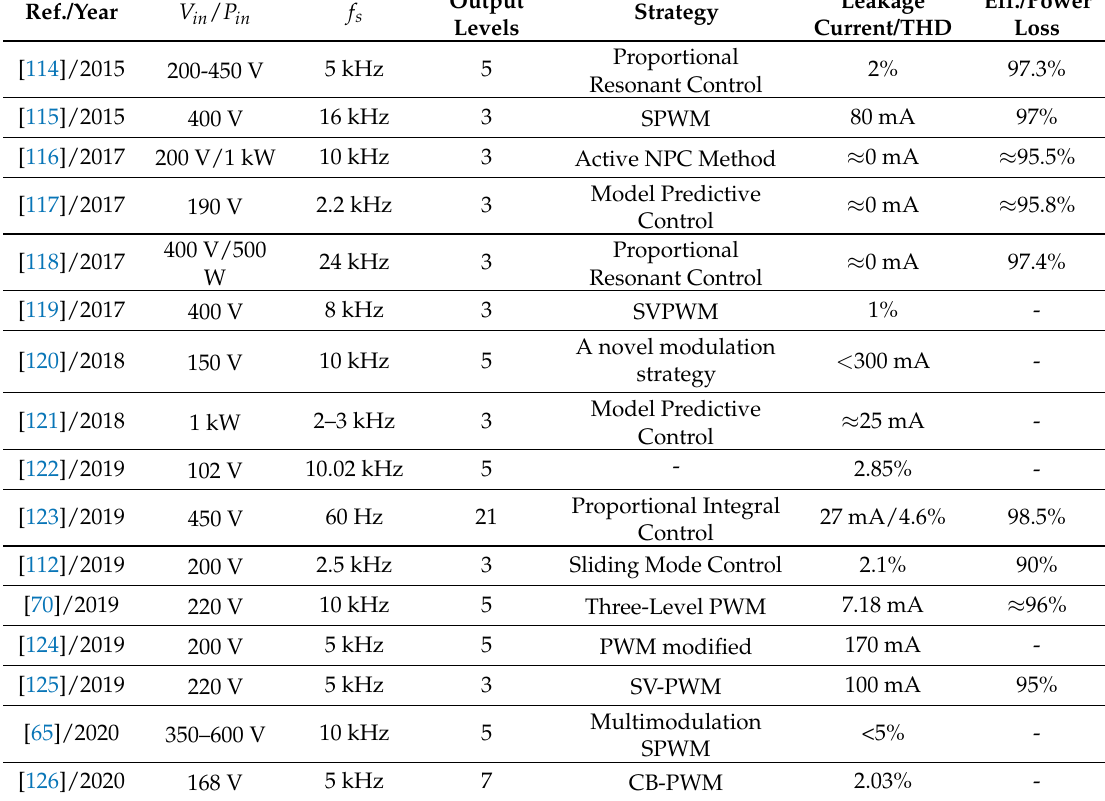
Table 13. Multilevel inverters used on PV